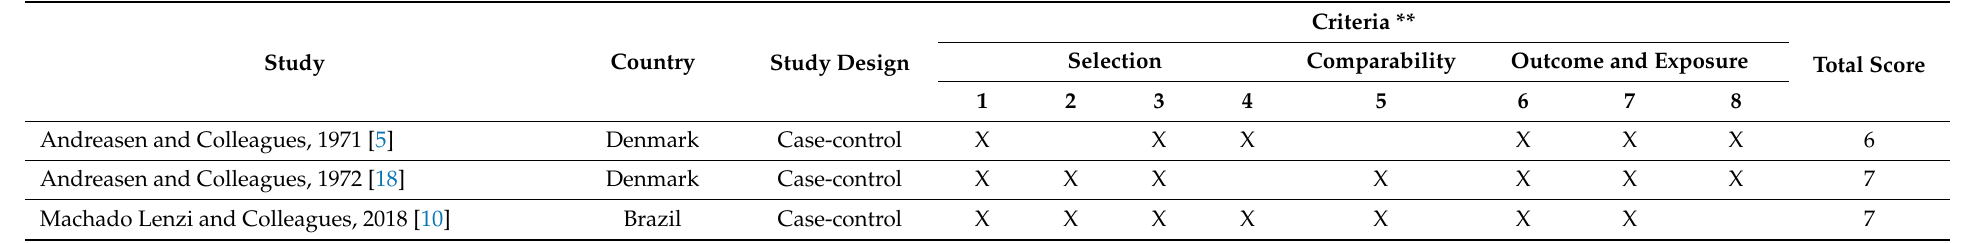
Table 2. Methodological quality for case-control studies, assessed using the Newcastle-Ottawa Scale *.